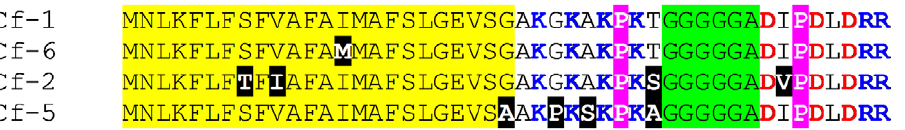
Figure 5. The cat flea Cys-less peptide family. ClustalW alignment showing the non-conserved residues in black background and the signal peptide in yellow background. Positively charged amino acids on the mature peptide are shown in blue color; acidic residues are shown in red. The GGGGGA motif is shown in green background. The conserved prolines flanking the glycine-rich motif are shown in pink background.